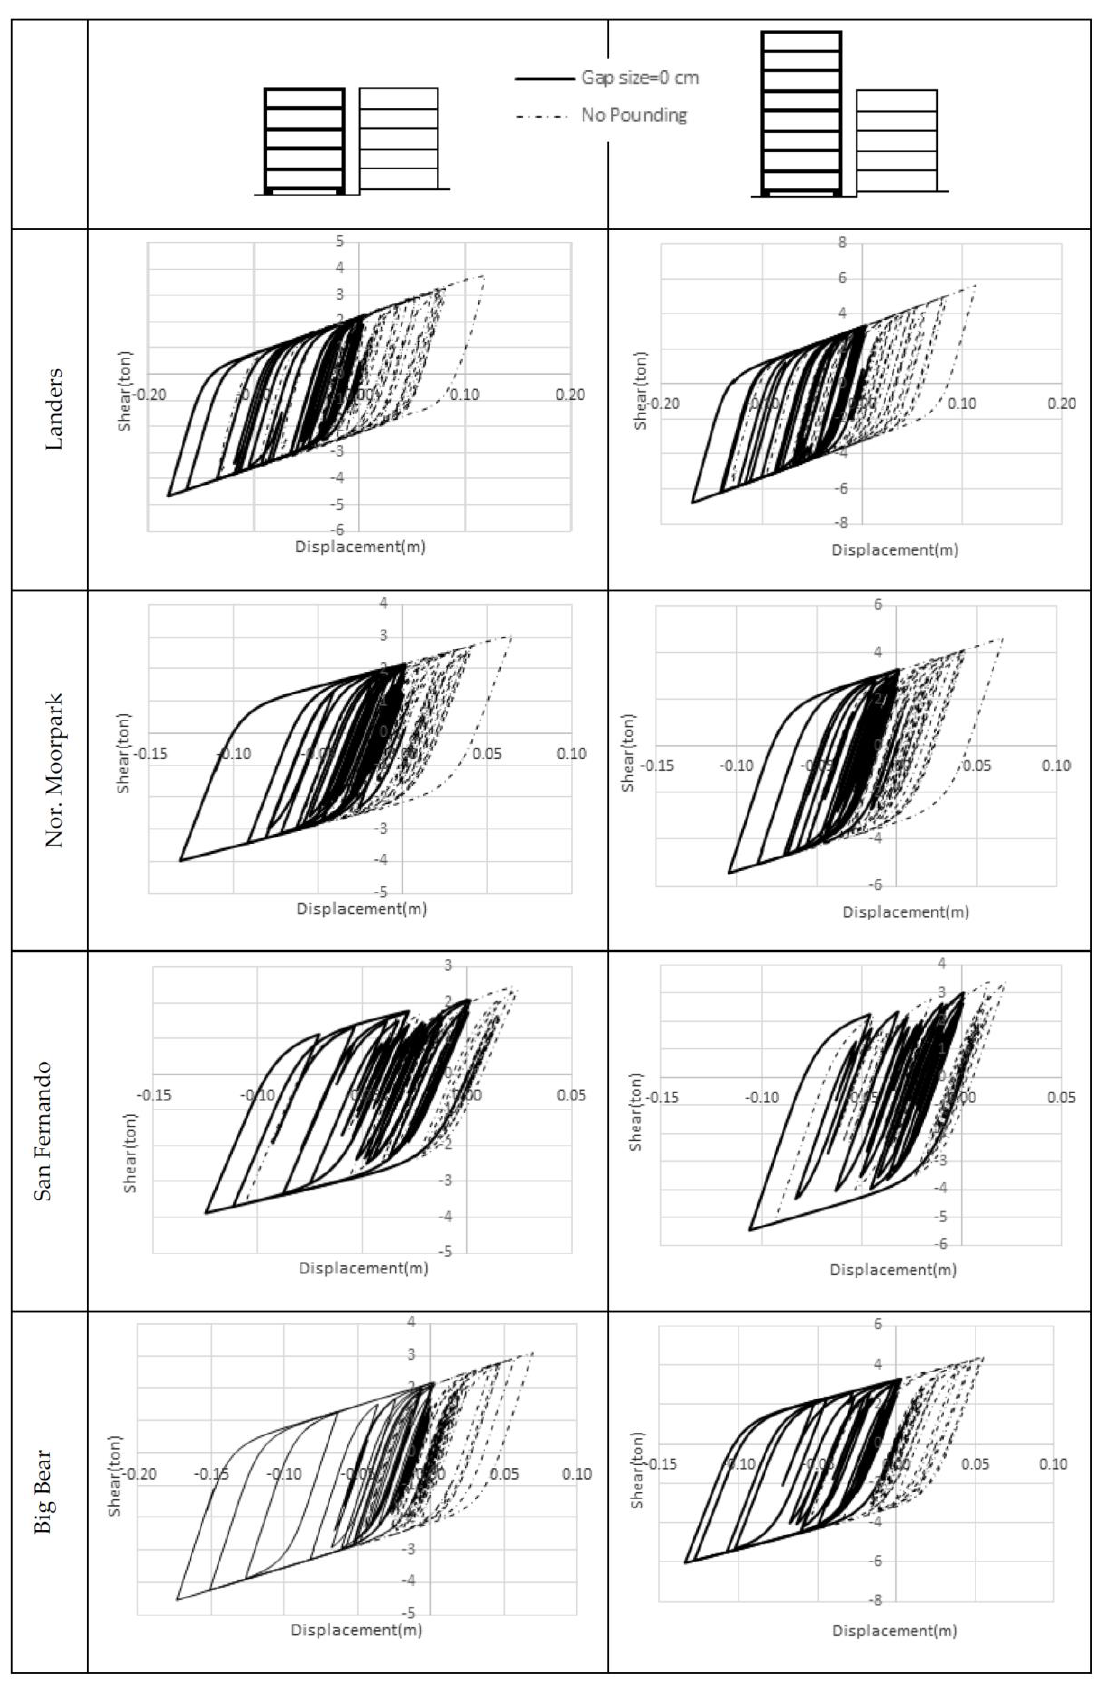
Figure 10. Hysteresis curves for isolators of the base-isolated building for pounding and no pounding cases during the Landers, Northridge (station: Moorpark), San Fernando, and Big Bear earthquakes.